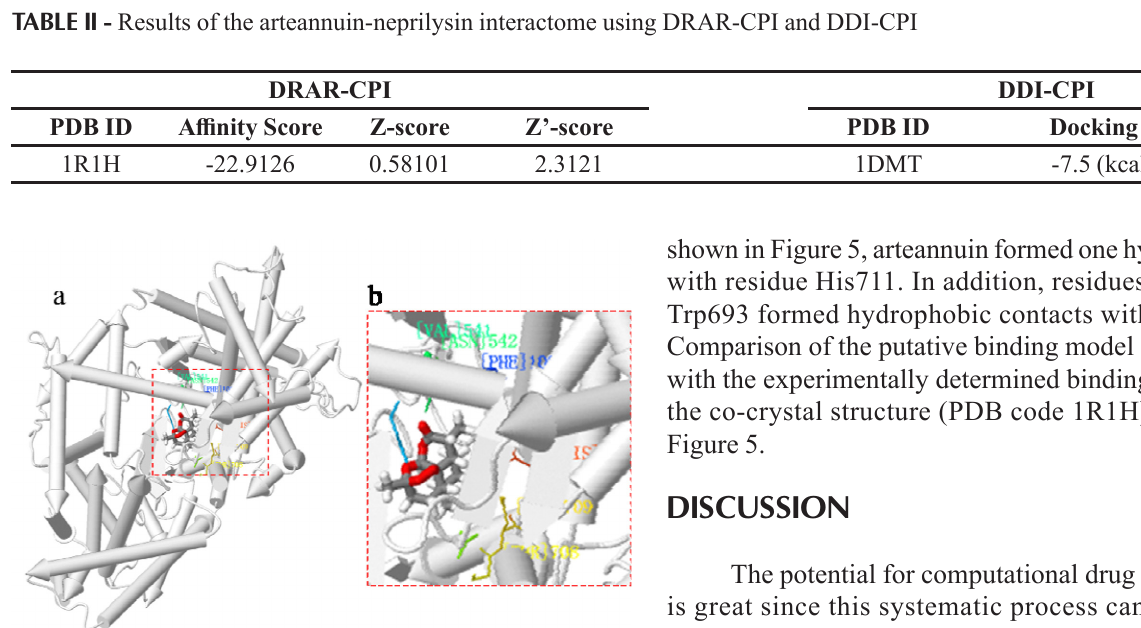
FIGURE 3 - Binding pattern of arteannuin and neprilysin (1DMT) obtained using the DRAR-CPI sever. (a) Overview. (b) Detailed view. The protein chain is shown in rocket representation, ligands are shown in stock representation, and key residues are coloured and shown in line representation.